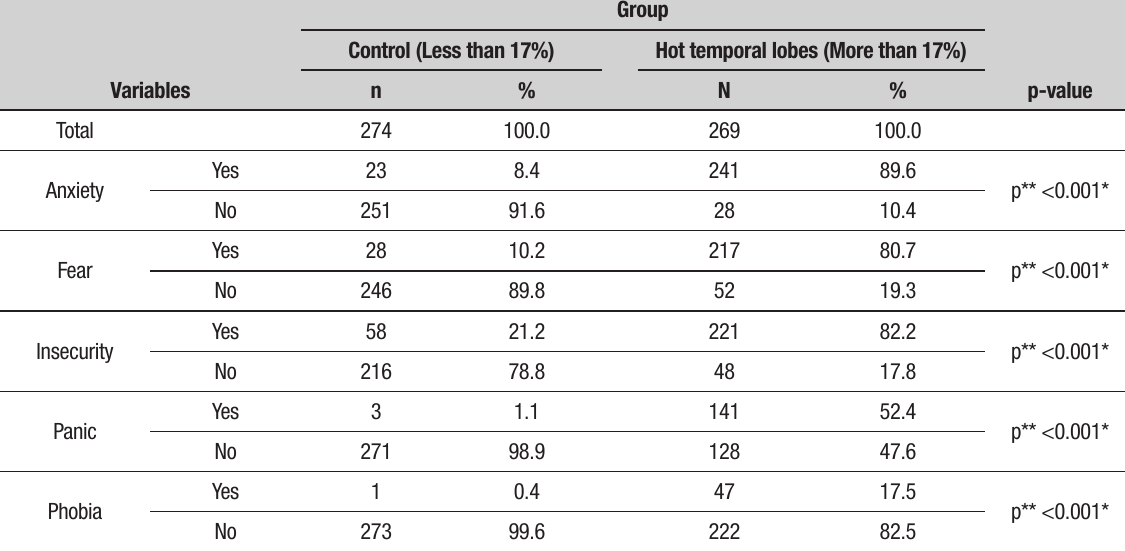
Table 2. Evaluation of symptoms according to group: Percent of High Beta (23-38 Hz) wave in left temporal lobe (T3) . Control (Less than Variables